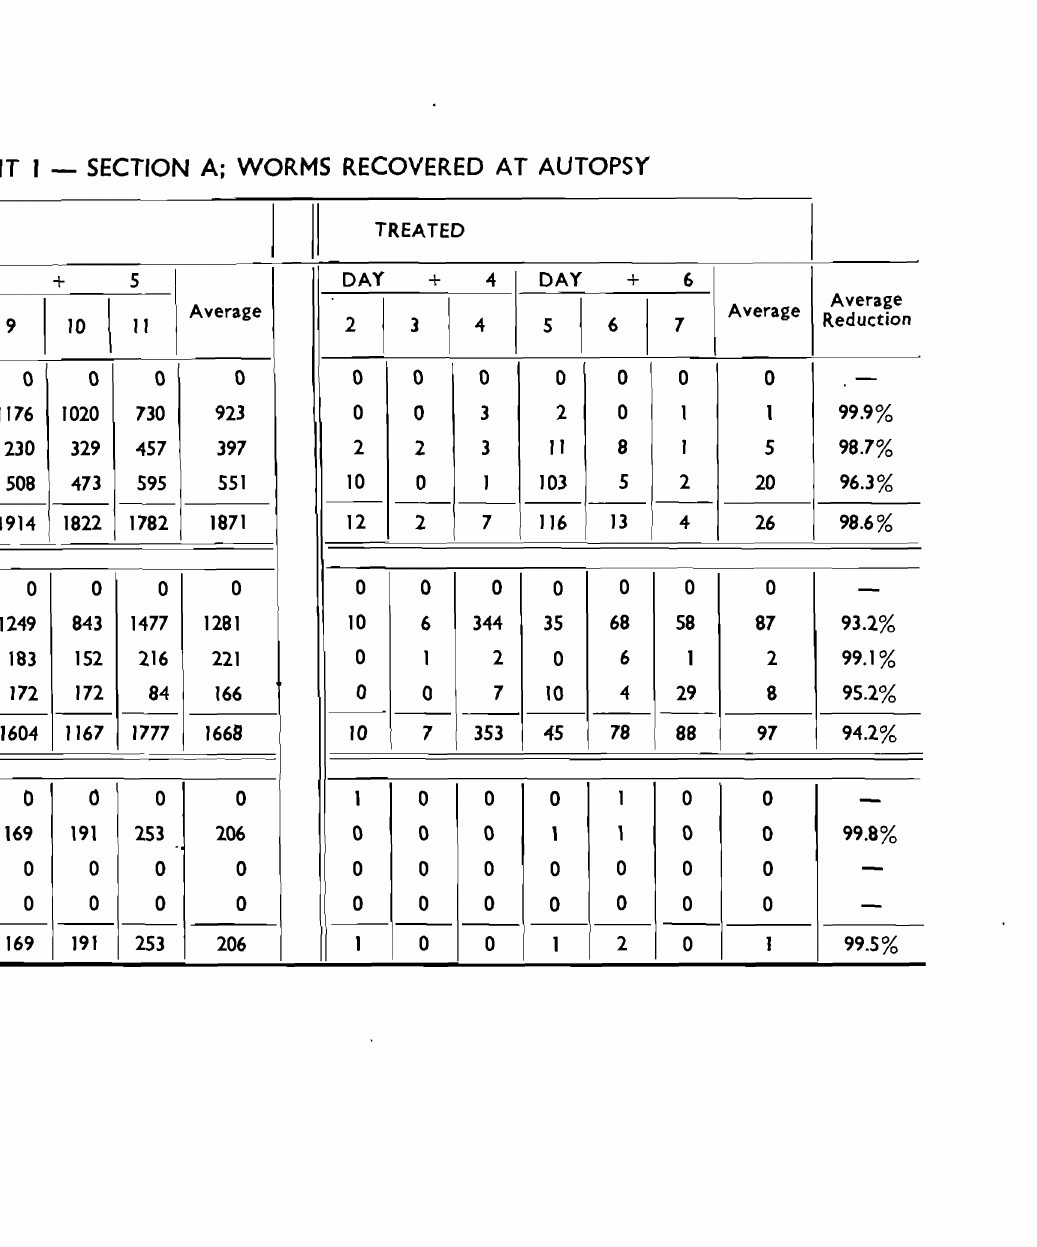
TABLE 4-EXPERIMENT J